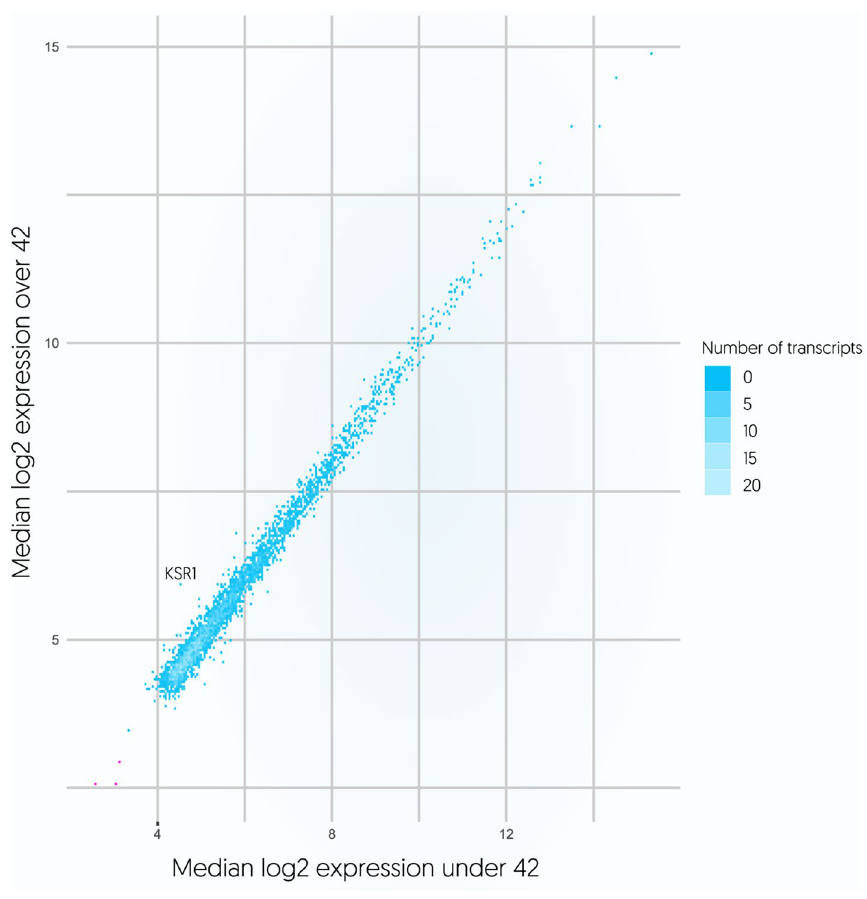
Figure 3. Plot representing the relation between log2 median spliced platelet RNA profile of donors younger (X axis) and older than 42 years (Y axis).